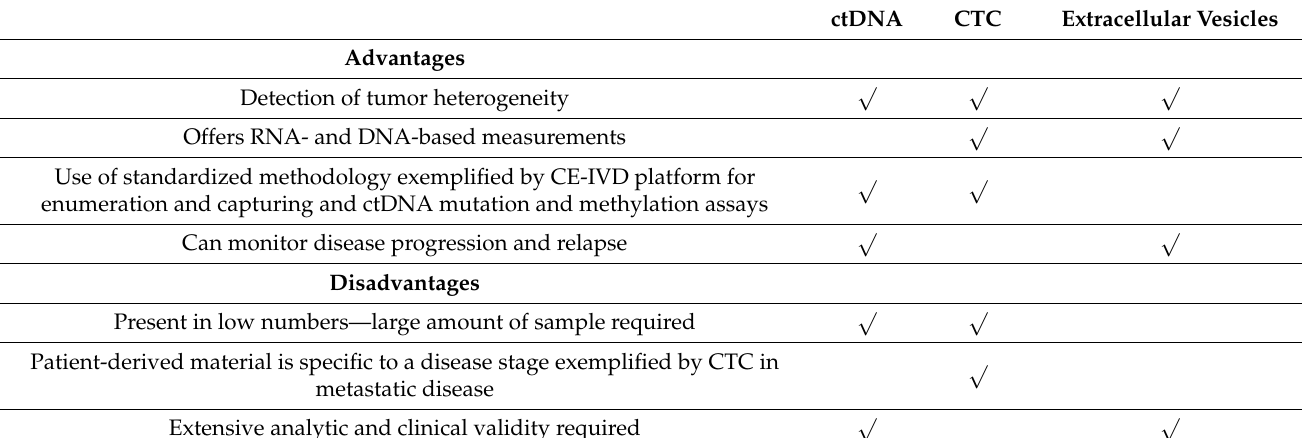
Table 3. Advantages and Disadvantages of the different liquid biopsy sources in relation to